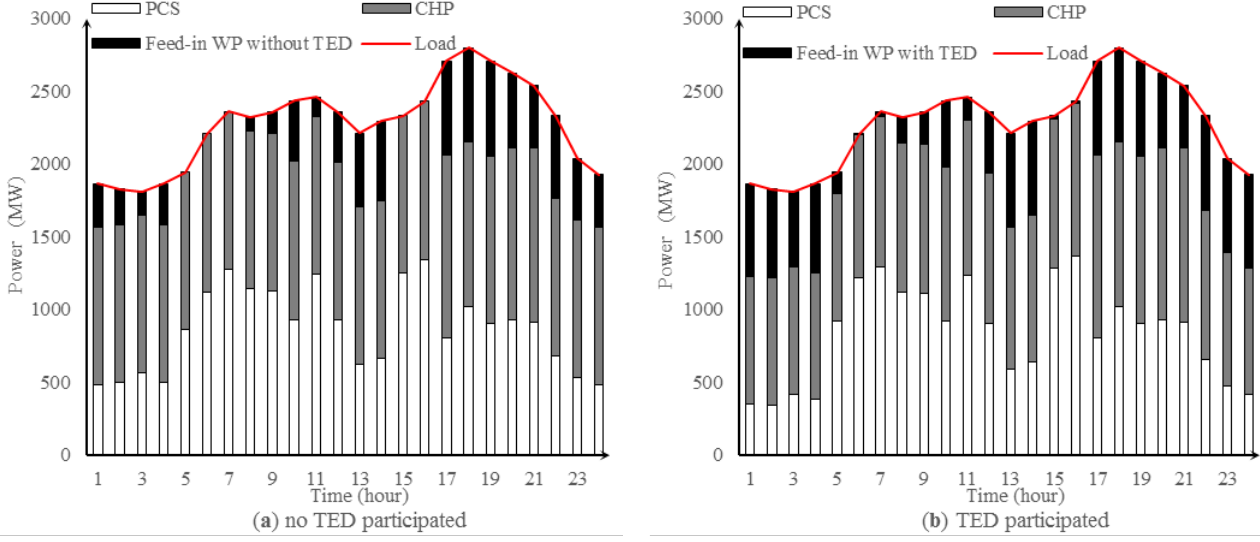
Figure 14. The ingredients of hourly electric power sources with/without